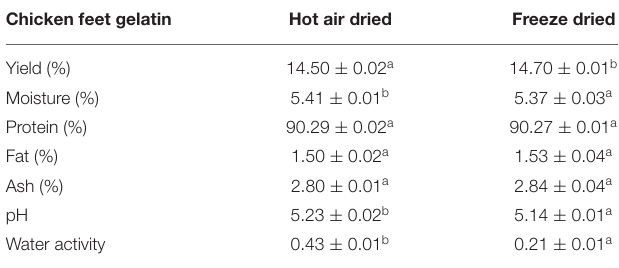
TABLE 1 | Yield, proximate composition, pH, and water activity of HAD and FD